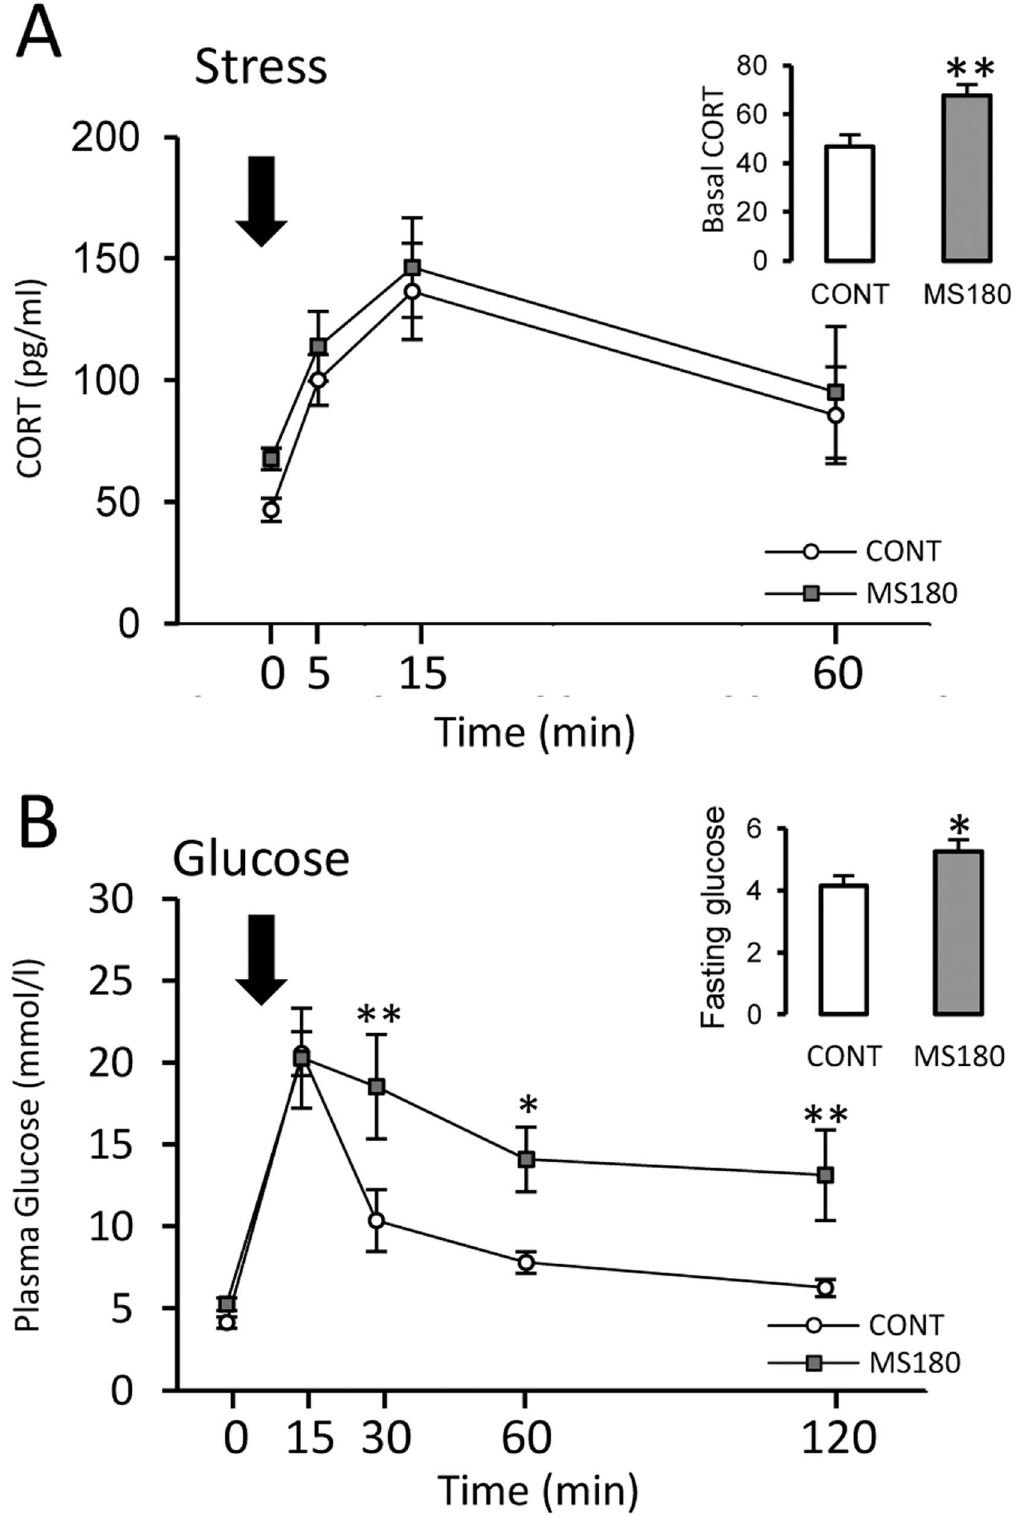
Fig 3. Maternal separationincreases basalHPA axis activityand impairsglucosehomeostasis. A) Corticosterone (CORT) plasmalevels of maternally separated(MS180)and control(CONT)adult males before